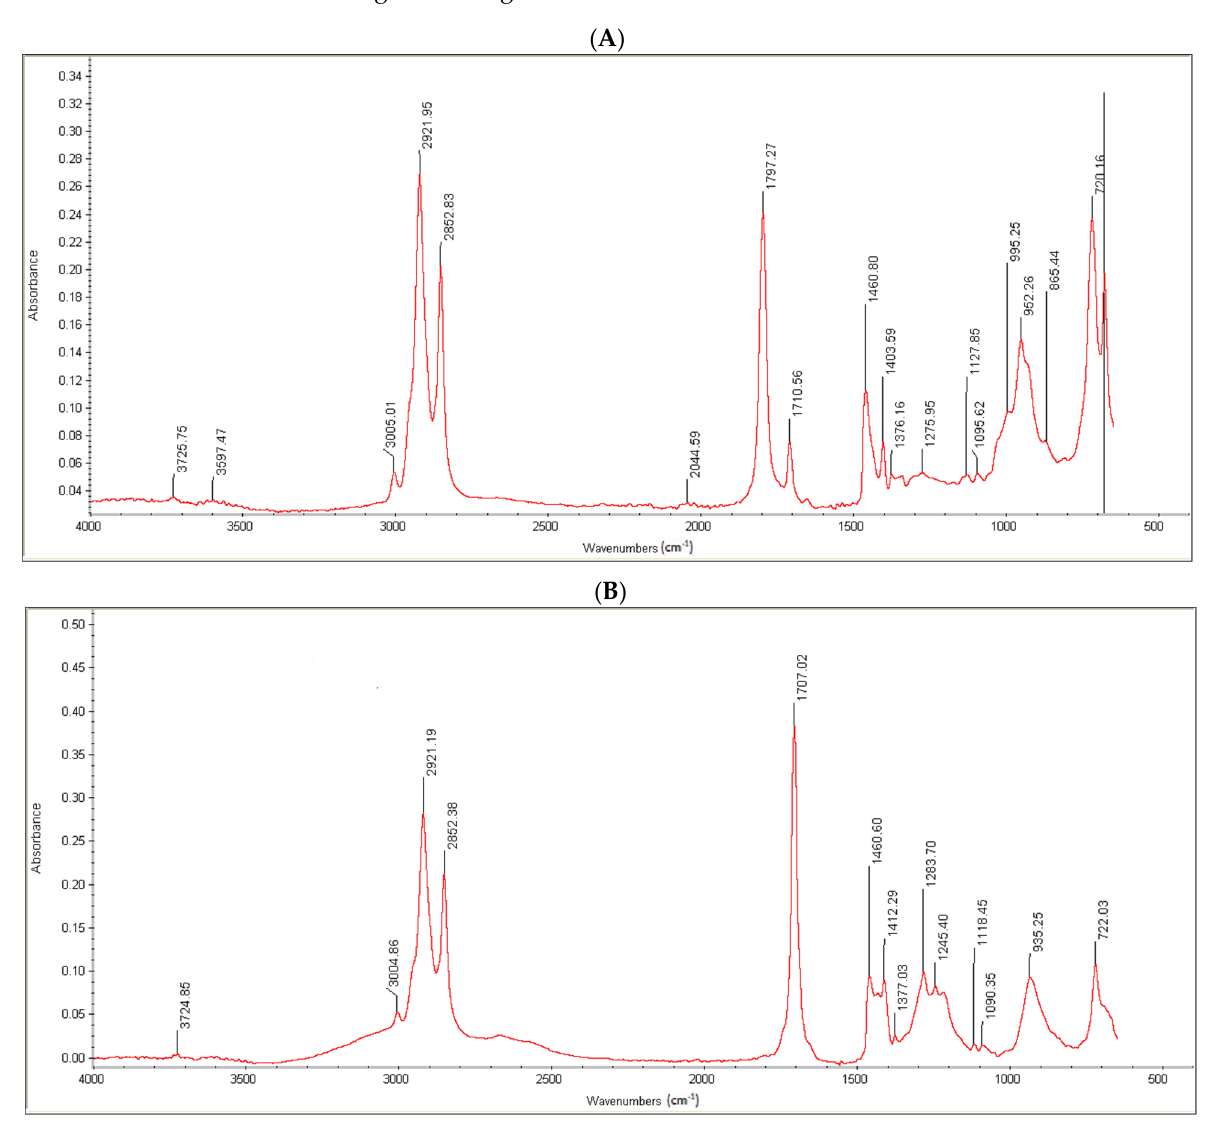
Figure 3. FTIR spectra of Oleoyl chloride ( A ) and OC-PAP conjugate ( B ).